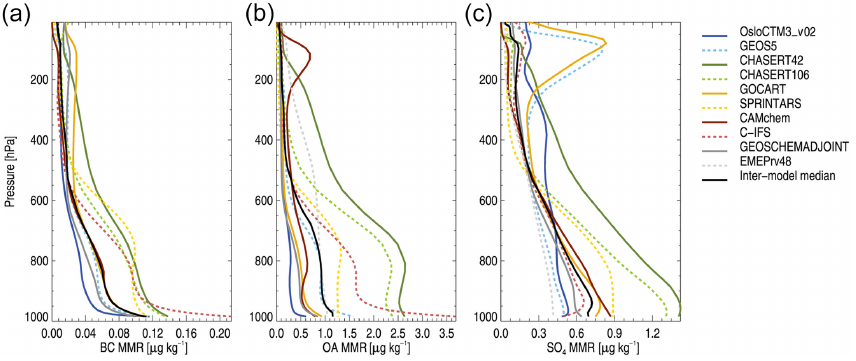
Figure 3. Globally and annually averaged mass mixing ratio (MMR) of (a) BC, (b) OA and (c) SO 4 , for all contributing models for the BASE